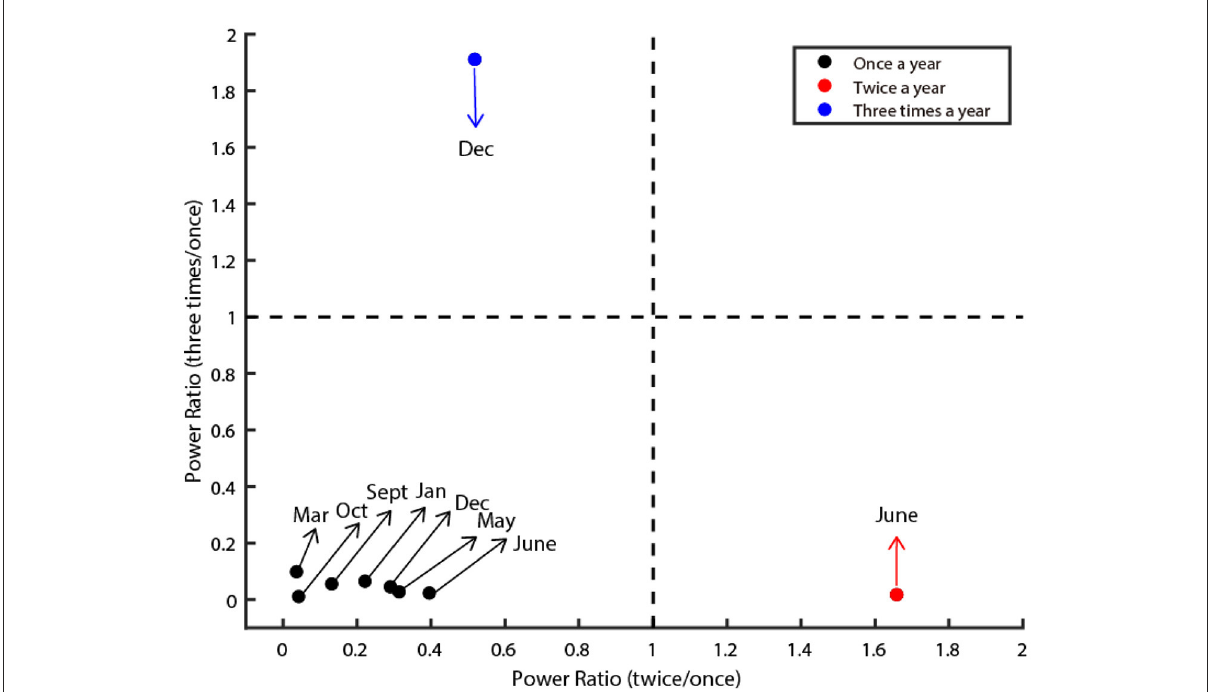
FIGURE2 Three oscillatory types of class C infectious diseases. The figure illustrates three clusters (denoted by red, black, and blue dots). The X-axis denotes the power ratio of occurrence between twice a year and once a year. The Y-axis denotes the power ratio of occurrence between three times a year and once a year. The dashed line is the criteria that separates them. The dots in the lower left depict diseases classified as Type I. The dots in the lower right corner depict diseases classified as Type II. The dots in the upper left corner are classified as Type III. The preferred month of each disease was marked by the